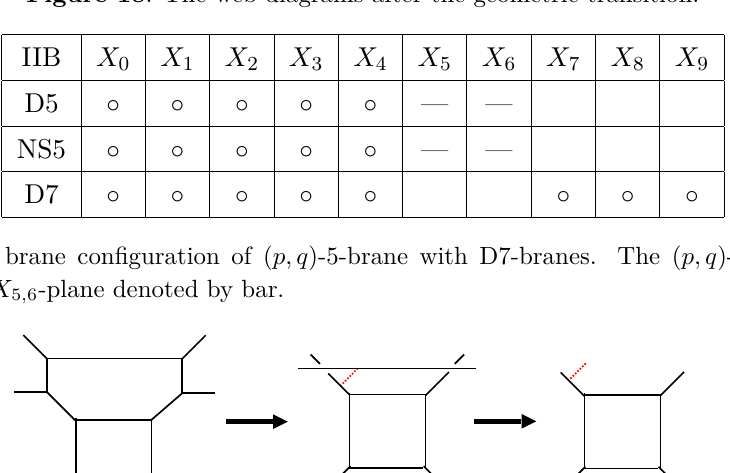
Figure 18 . The web diagrams after the geometric transition.